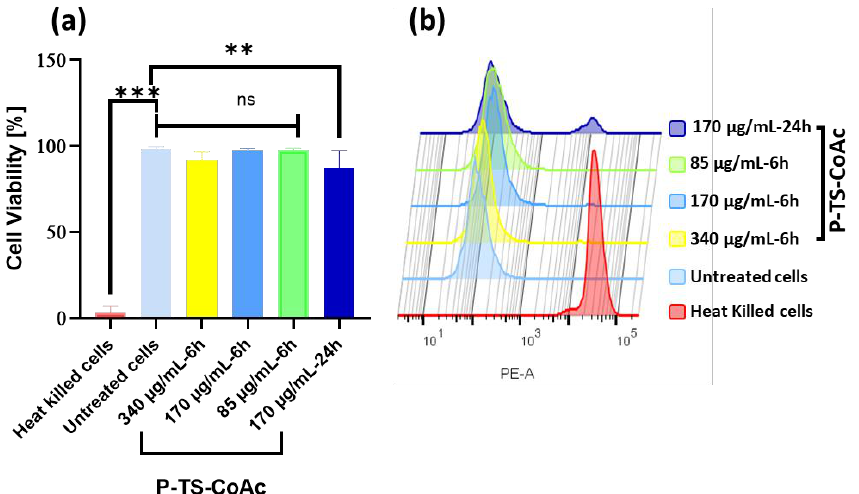
Figure 5. Cytotoxicity assay of P-TS-CoAc in DC2.4 murine dendritic cell line using fixable dead stain (568/583) ( a ) % Cell viability following 6 h incubation of P-TS-CoAc (340,170 or 85 µg/mL) or 24 h incubation of P-TS-CoAc (170 µg/mL) ( N = 3, n = 3); ** p < 0.01, *** p < 0.001, ns = not significant. ( b ) Fluorescence intensity (dead stain uptake) of cells following different treatments.